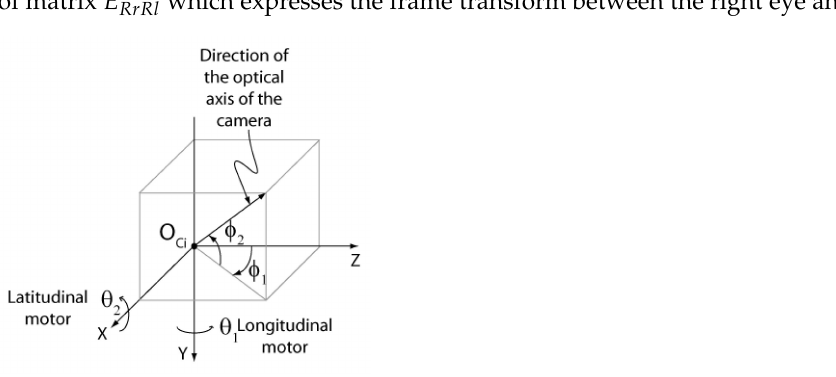
Figure 6. Definition of the angles for the motors and the rotation of the camera reference